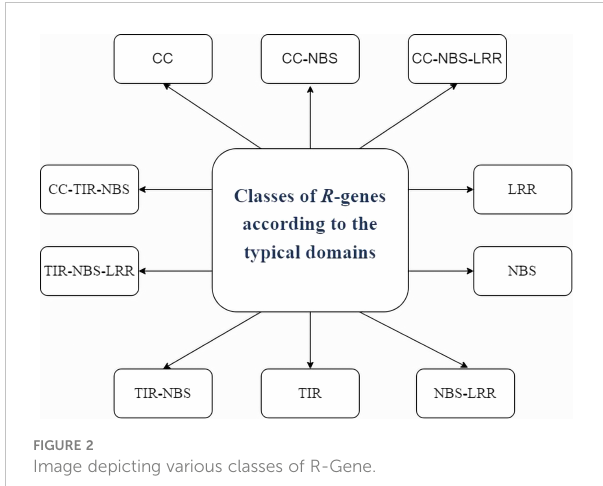
FIGURE 2 Image depicting various classes of R-Gene.